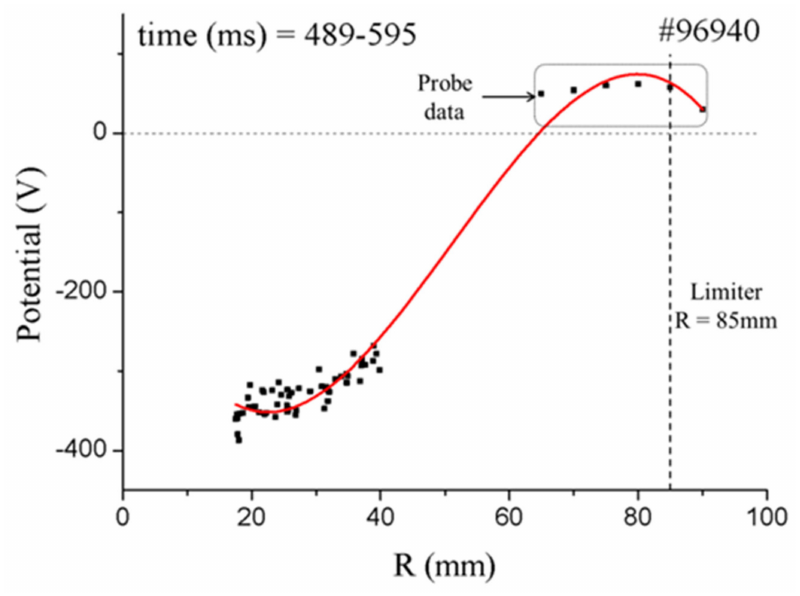
Figure 25. Plasma potential measurement by the HIBD in the plasma core of ISTTOK (reprinted from